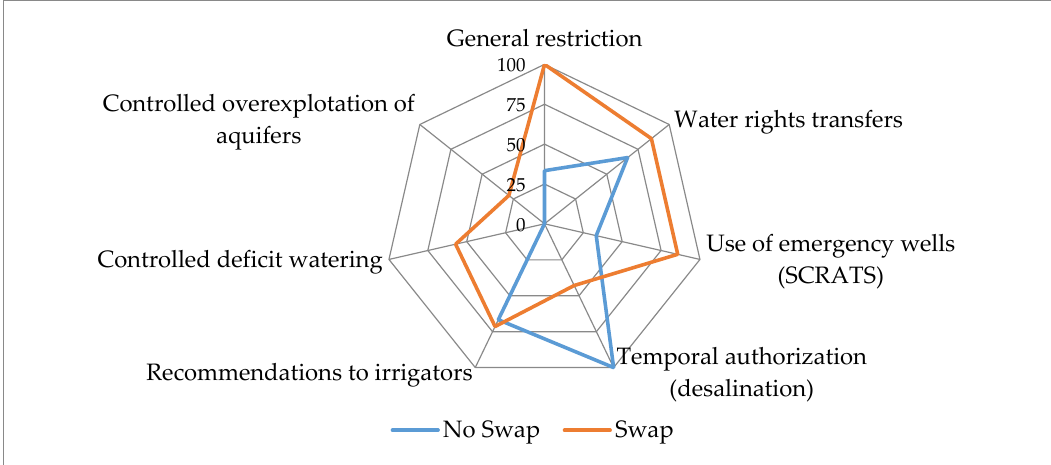
Figure 4. Measures applied to solve under-provision of water according to irrigation communities’ involvement in the swap system (in percentage).